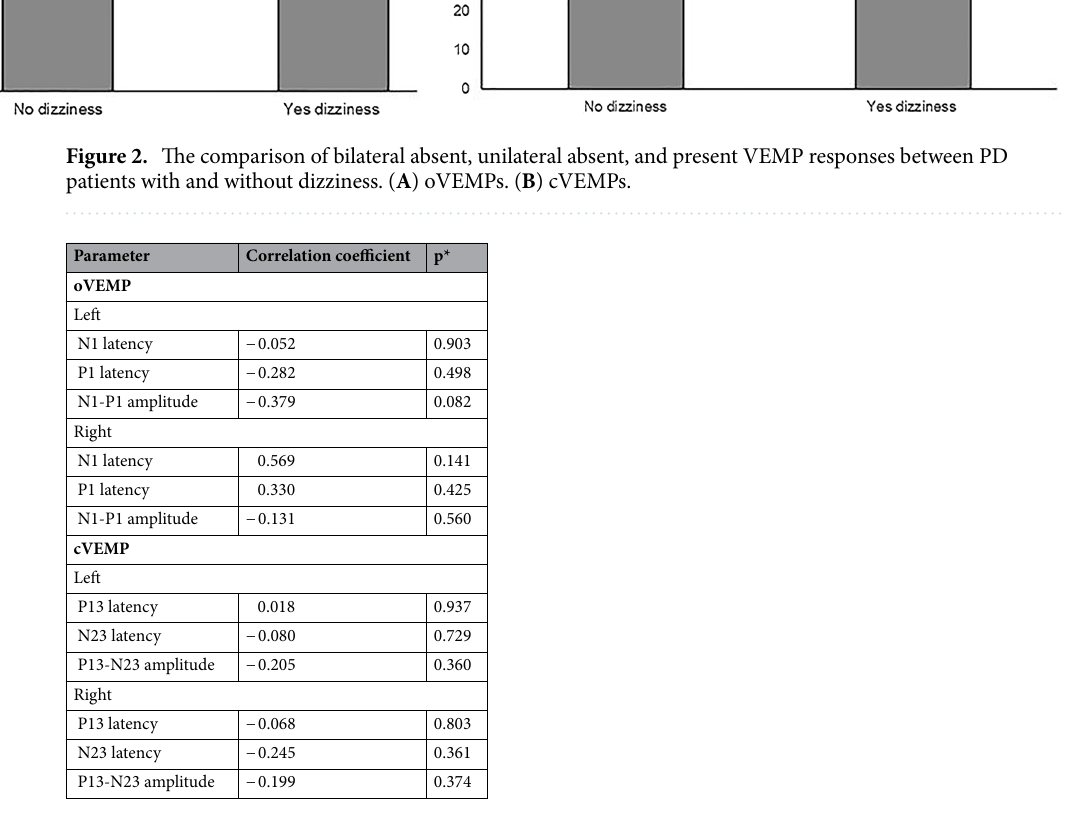
Table 2. Partial correlations between the dizziness severity and VEMP parameters. *p < 0.05 indicates a significant correlation.